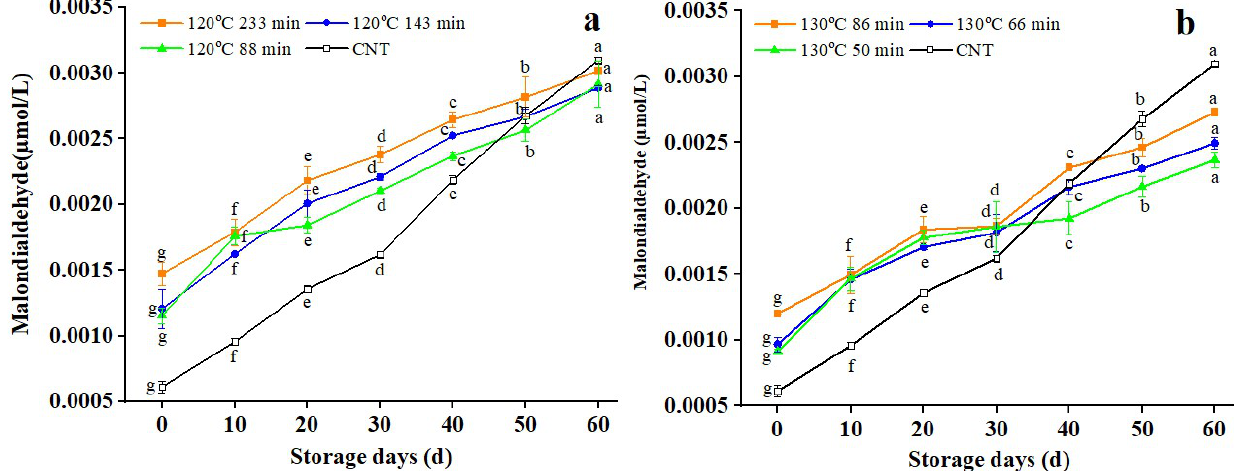
Figure 5. Changes in malondialdehyde content in rice bran after dry-heated treatment. Note: The lowercase letters refer to the significant difference of the same sample for different storage periods at the same temperature and treatment conditions at p < 0.05. CNT: Control.